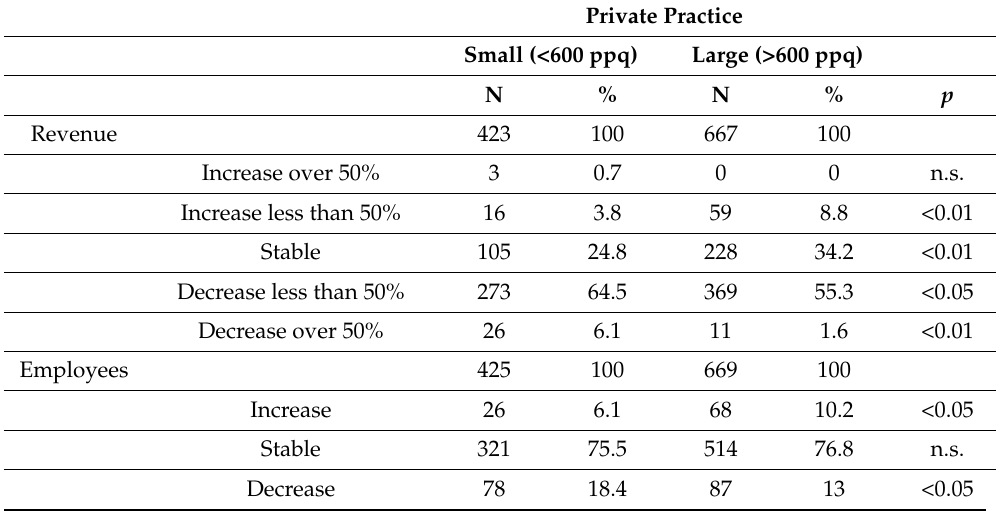
Table 8. Development of procedures.